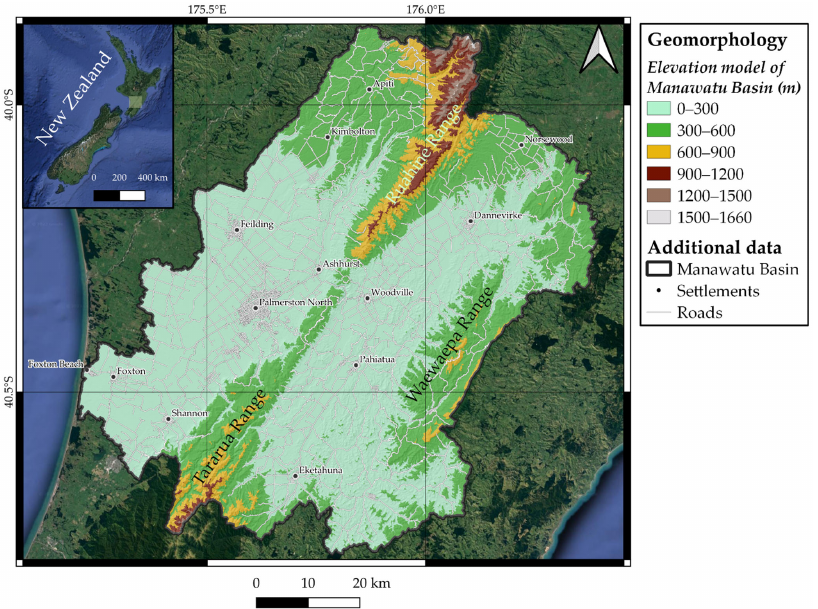
Figure 1. Overview map and elevation model of Manawatu Basin created from Shuttle Radar To ‐ pography Mission (SRTM) 1 Arc ‐ Second Global (https://www.usgs.gov/centers/eros/science/usgs ‐ eros ‐ archive ‐ digital ‐ elevation ‐ shuttle ‐ radar ‐ topography ‐ mission ‐ srtm ‐ 1, accessed on 15 December 2022); background is Google terrain map. The coordinate system is WGS 84 (EPSG: 4327), the same in all other figures.